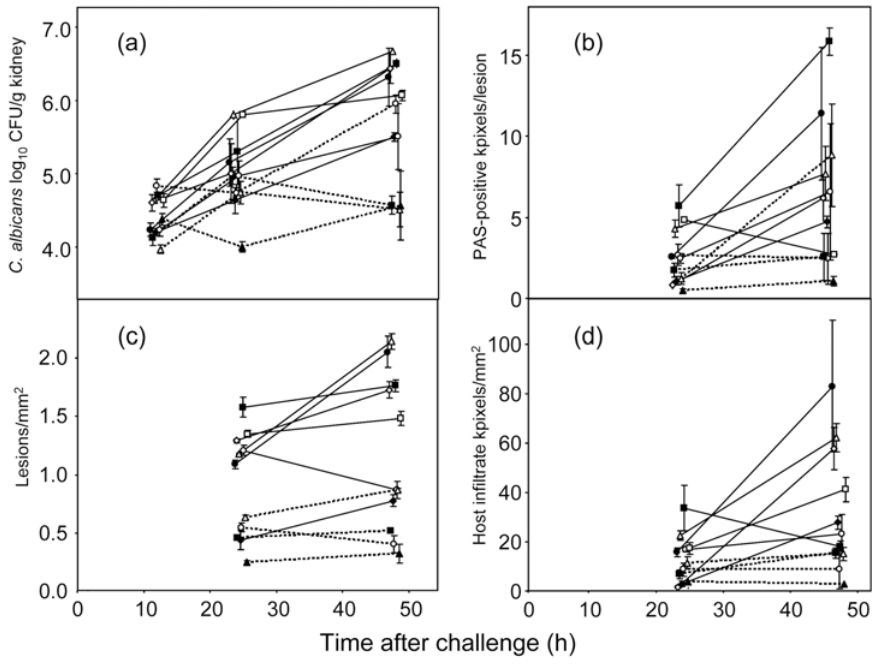
Figure 2. Development of kidney lesion parameters over 48 h from intravenous challenge of mice with 11 C.albicans strains. Data show means 6 SEMs for data from 3 mice per time point per strain. X-axis values have been jittered to facilitate visualization of the data. (a) Viable fungal burdens in kidneys. (b) C. albicans per lesion as PAS-positive pixels/lesion. (c) Lesion density (lesions/kidney section). (d) Host infiltrate pixels/ mm 2 . Strains are depicted as follows. J990102, open circles; J951361, filled squares; AM2003-020, open triangles; IHEM16614, open diamonds; SC5314, closed circles; s20175.016, open squares; AM2003/0074, filled diamonds; AM2003/0069, open circles with dotted lines; HUN96, filled squares with dotted lines; Capmr1 , open triangles with dotted lines; Capmr1 + PMR1 , filled triangles with dotted lines.